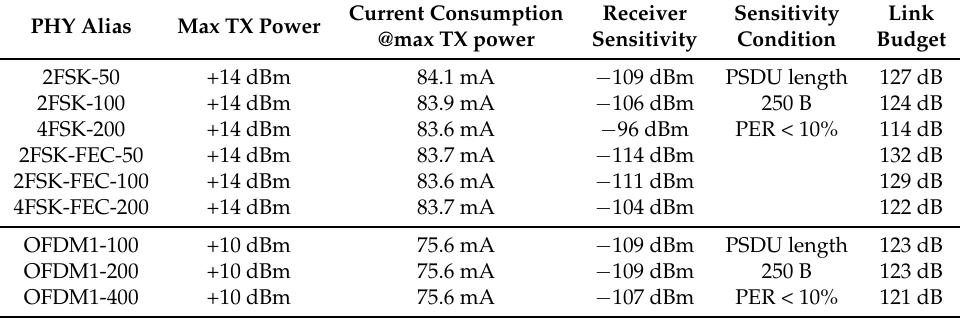
Table 6. Radio characteristics of the ATREB215 XPRO Extension board featuring the